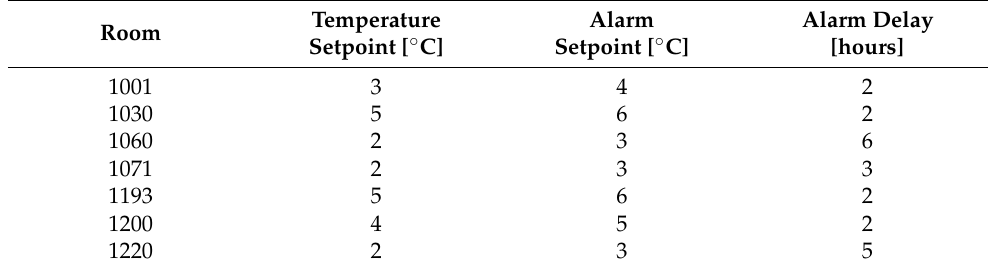
Table 3. Facility room-temperature constraints.